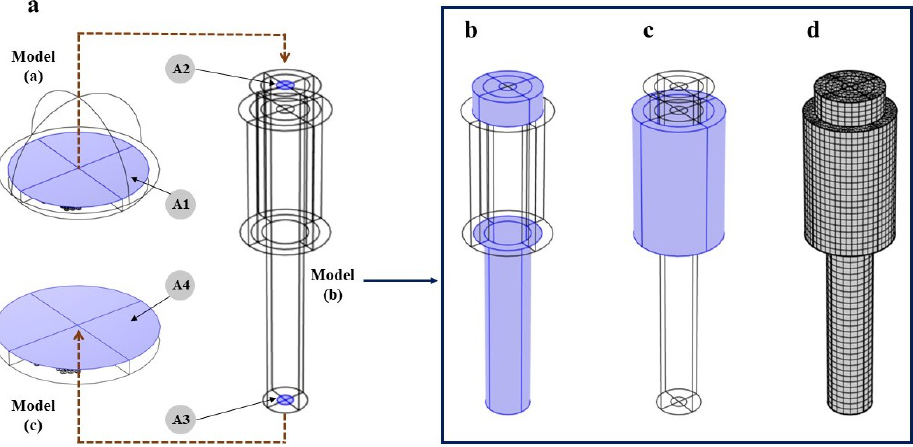
Figure 11. ( a ) The bolt head and end/silicone layer interfaces in the three models. ( b ) Free BC. ( c ) Absorbing boundary layer added as an additional exterior layer surrounding the plates structure to simulate an infinite domain with respect to the acoustic minimum wave length ( λ s ) in solid domain. ( d ) Bolted joint meshed using quadratic wedge elements for the elastic wave propagation